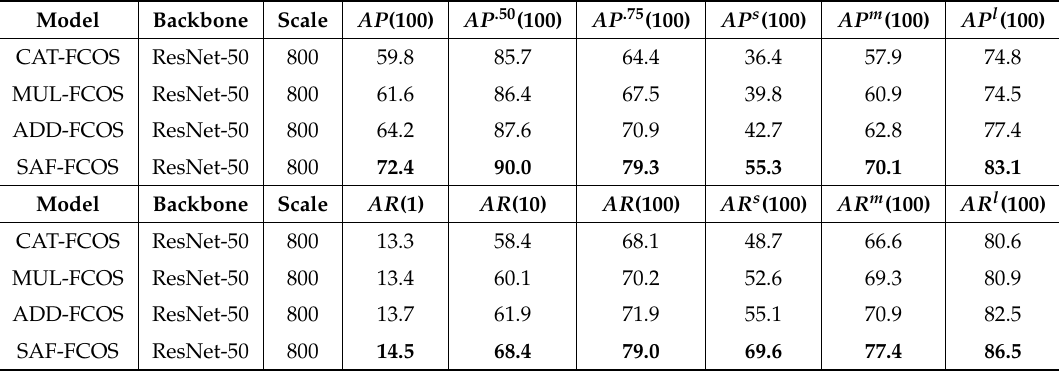
Figure 10. The loss and AP plots about FCOS and SAF-FCOS in different iterations. Table 2. Obstacle detection comparisons using different feature fusion blocks on the nuScenes test dataset [37]. The top sub-table is about average precision metrics. In addition, the bottom sub-table is about average recall